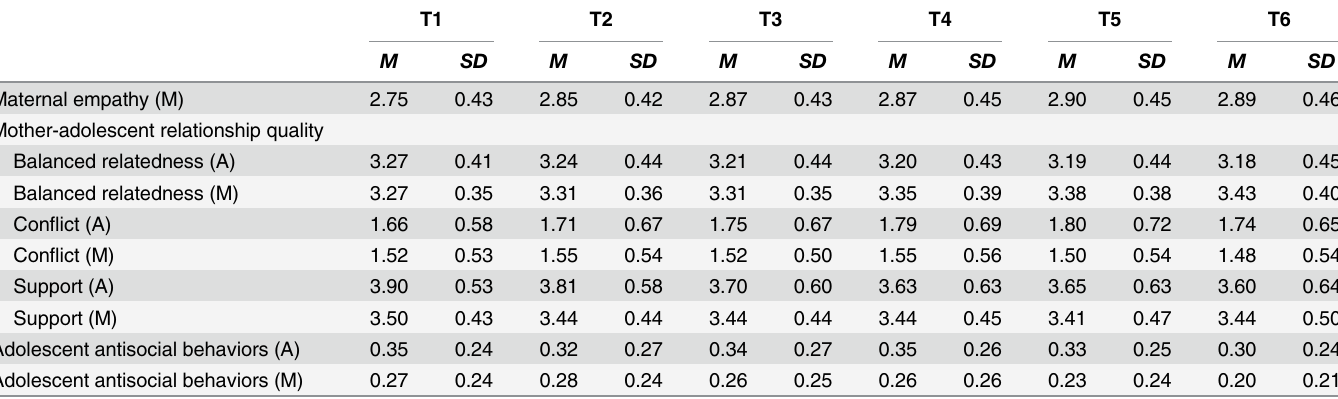
Table 1. Means (M) and Standard Deviations (SD) for Study Variables.